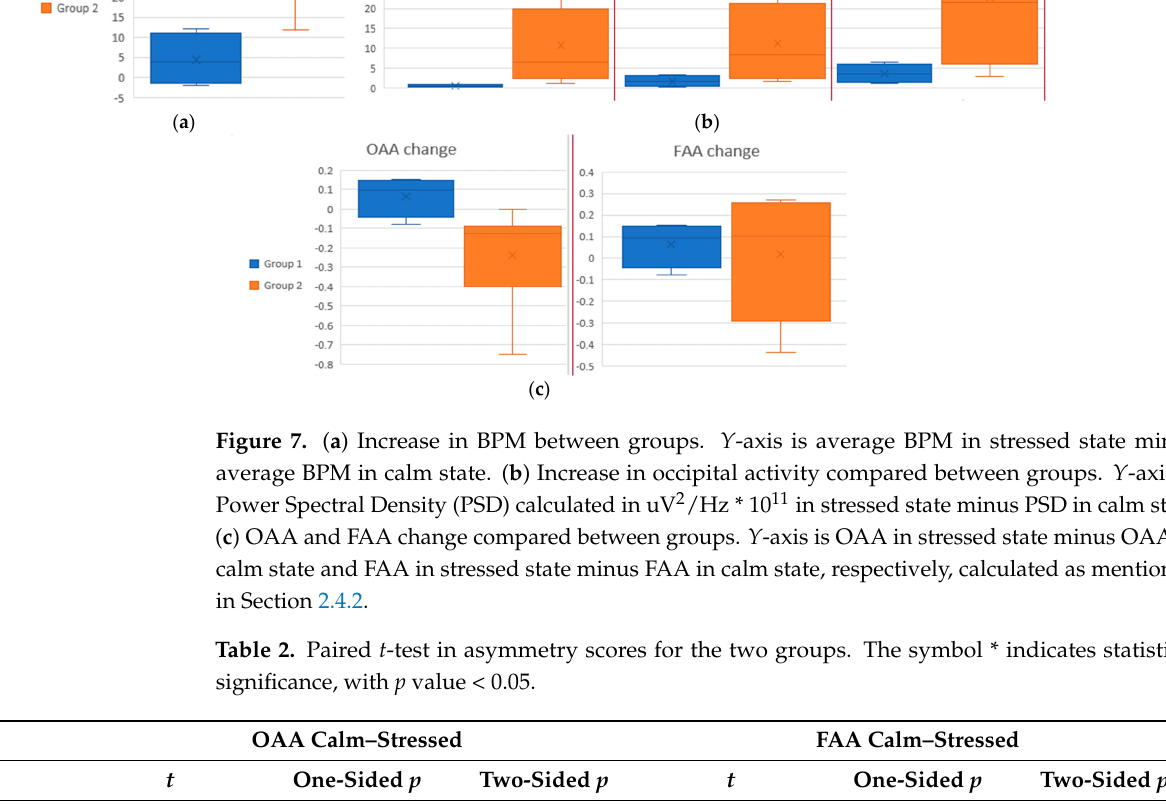
Table 2. Paired t -test in asymmetry scores for the two groups. The symbol * indicates statistical